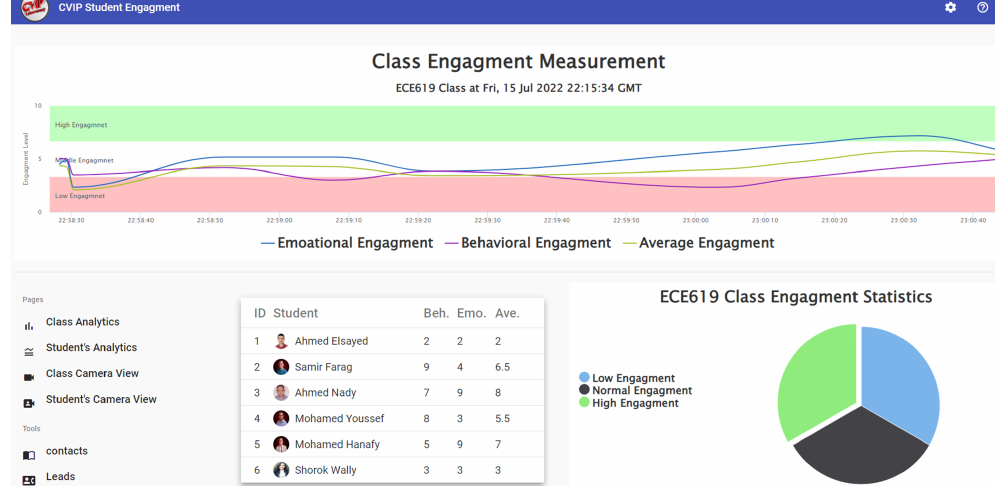
Figure 8. Instructor dashboard summarizes class students’ engagement in a clear and simplified